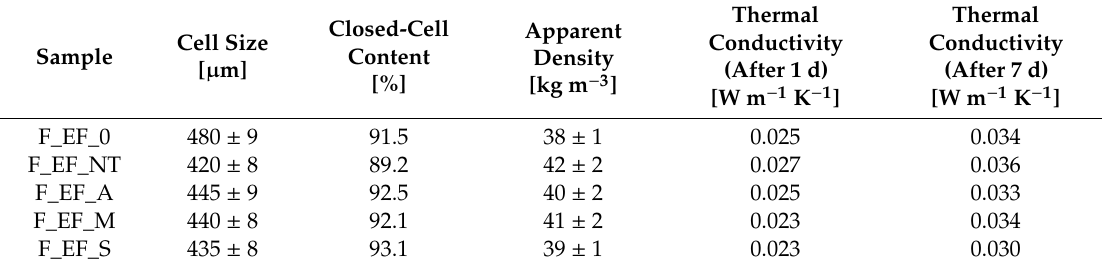
Table 3. Structural parameters and thermal conductivity results of polyurethane foams modified with eucalyptus fibers.